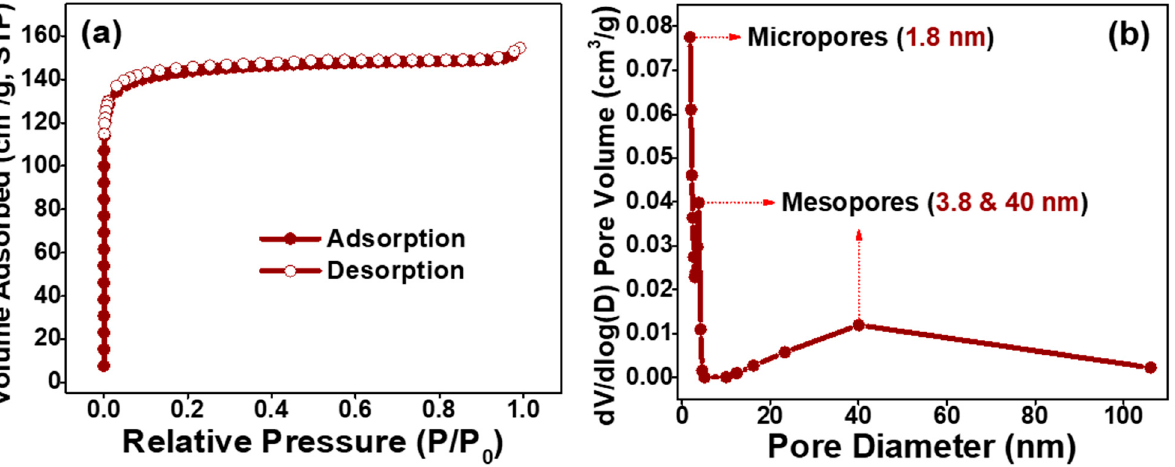
Figure 4. ( a ) Nitrogen adsorption-desorption isotherms of the prepared ATC and the corresponding ( b ) pore size distribution graph.